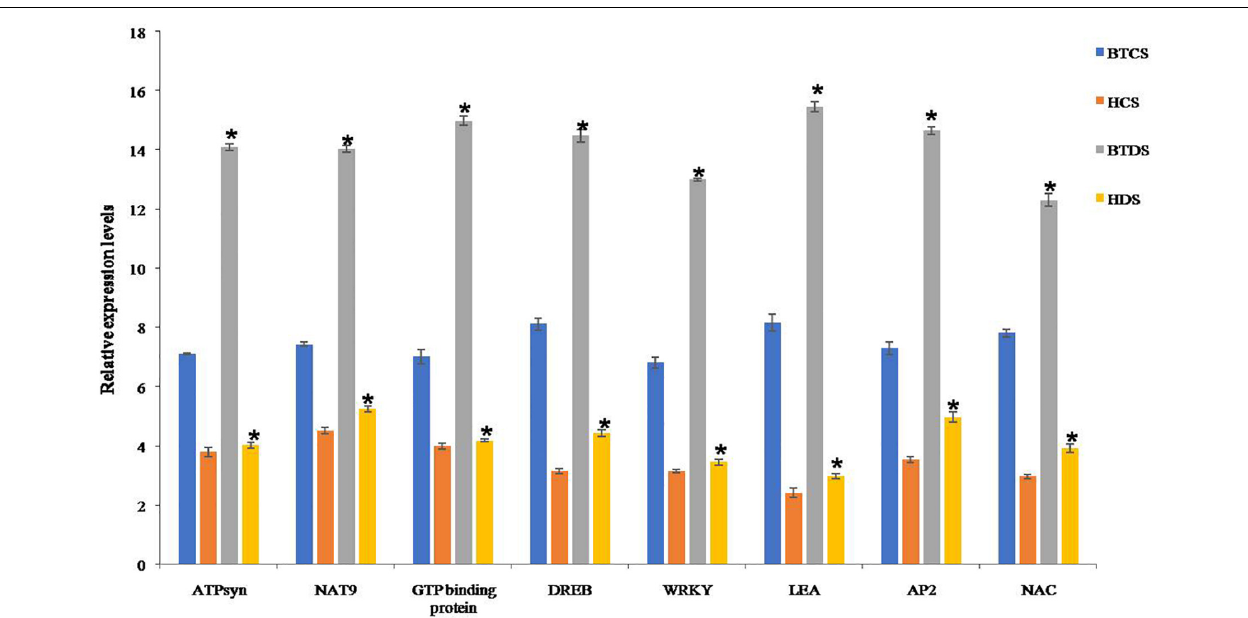
FIGURE 6 | Real-time PCR analysis of ATP Syn, NAT9, GTP-binding protein, DREB, WRKY, LEA, AP2/ERF, and NAC genes in BT and Non-BT cotton variety plants under drought stress conditions. Relative transcript levels of genes in BT and Non-BT cotton plants subjected to 2000 mM mannitol stressed condition were analyzed using real-time PCR. Actin gene was used as a reference. Bar represents mean, and I represents SE from three independent experiments. Asterisk indicates significant differences in comparison with Non-BT at P <